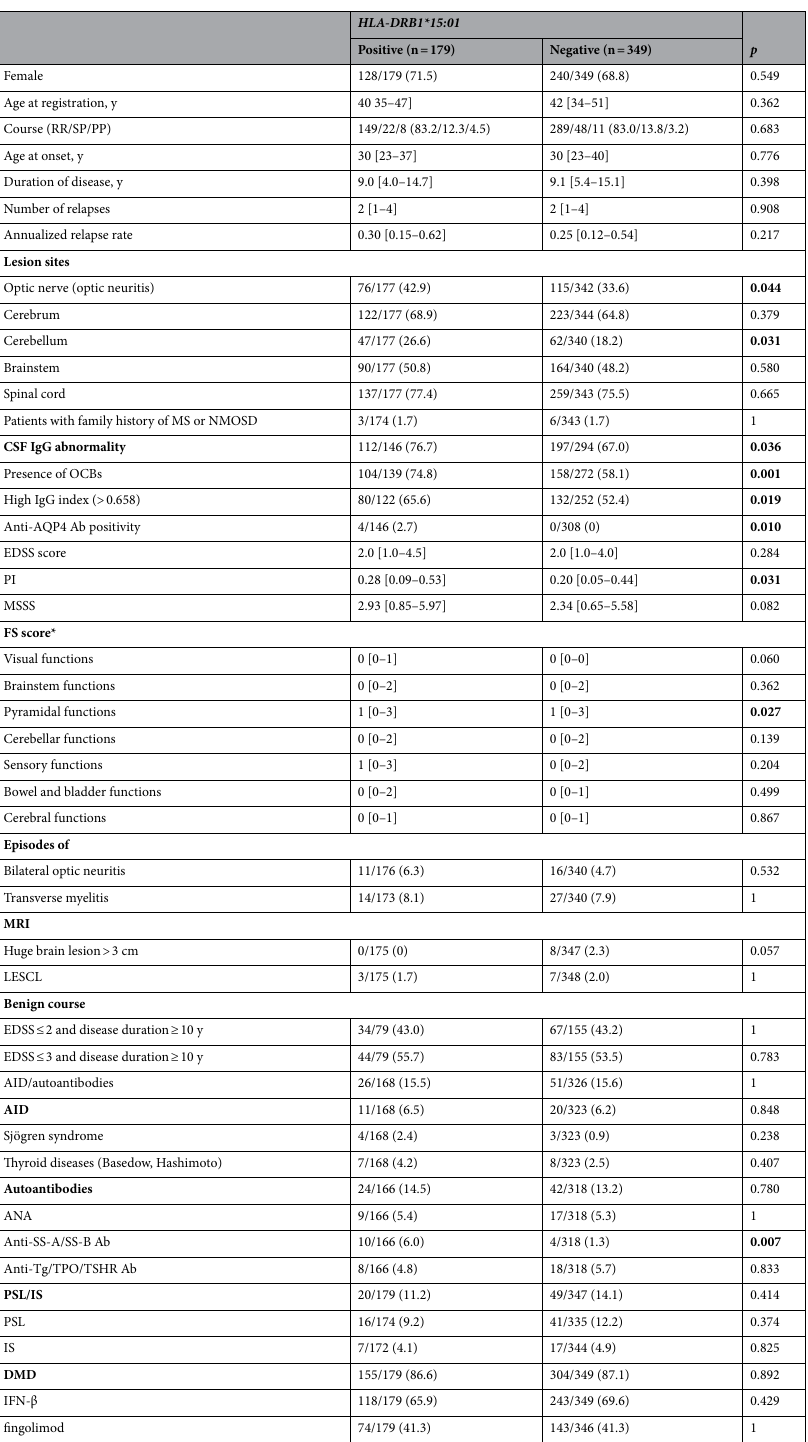
Table 7. Comparison of the clinical characteristics between MS patients with and without HLA-DRB1*15:01 . Bold values indicate significant differences. Values are median [interquartile ranges] or count (%). Ab , antibody, AID autoimmune disease, ANA , anti-nuclear antibody, AQP4 aquaporin 4, CSF cerebrospinal fluid, EDSS , expanded disability status scale, FS functional system, IFN interferon, IS immunosuppressants, LESCL longitudinally extensive spinal cord lesion, MS multiple sclerosis, MSSS multiple sclerosis severity score, NMOSD neuromyelitis optica spectrum disorders, OCBs oligoclonal IgG bands, PI Progression Index, PP primary progressive, PSL prednisolone, RR , relapsing–remitting, SP secondary progressive, Tg thyroglobulin, TPO thyroid peroxidase, TSHR thyroid stimulating hormone receptor, y years. *In the section of functional system scores, values are median [10-90th